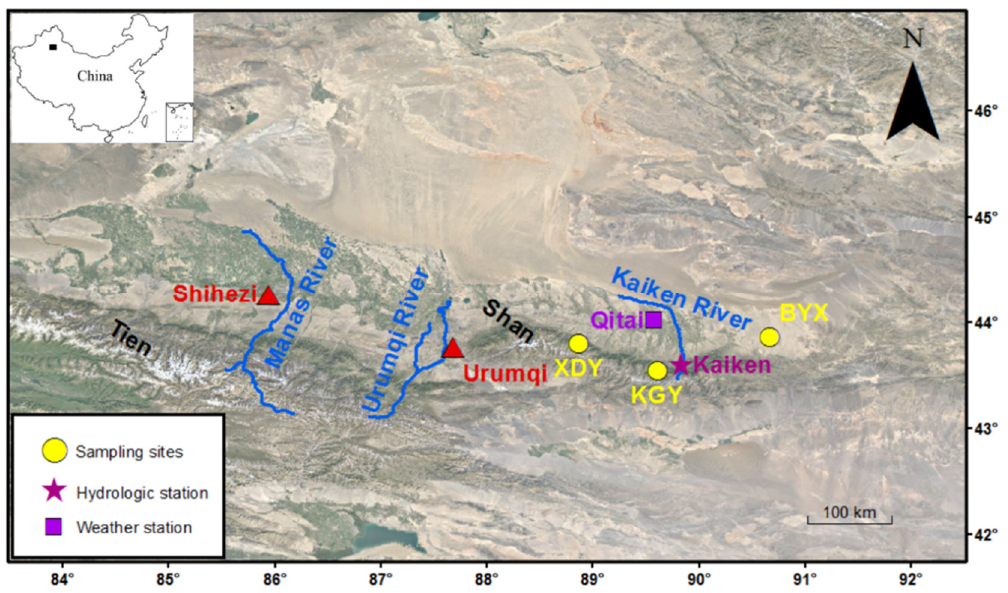
Table 1. Information about the sampling sites in the Kaiken River Basin.